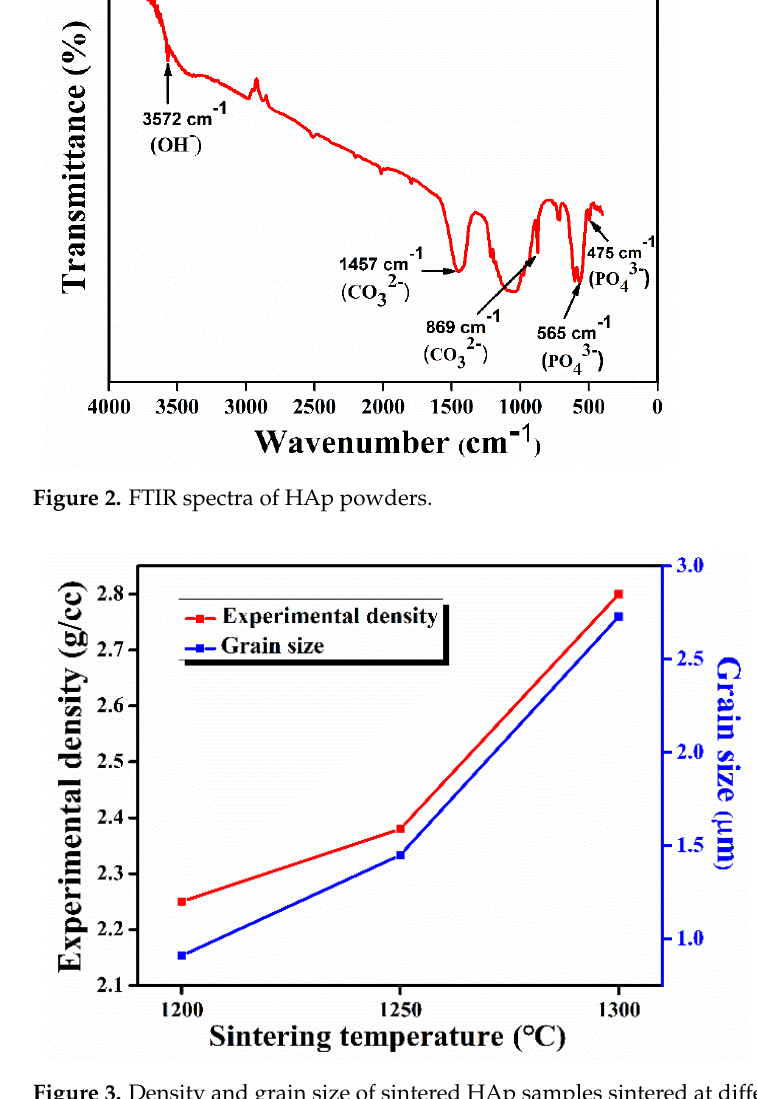
Figure 3. Density and grain size of sintered HAp samples sintered at different temperatures.